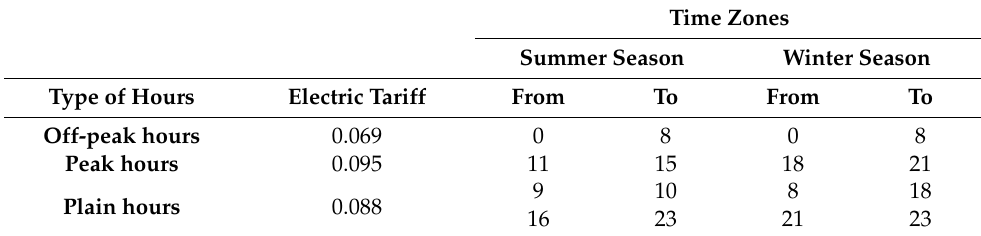
Table 3. Electric tariff for different time zones.